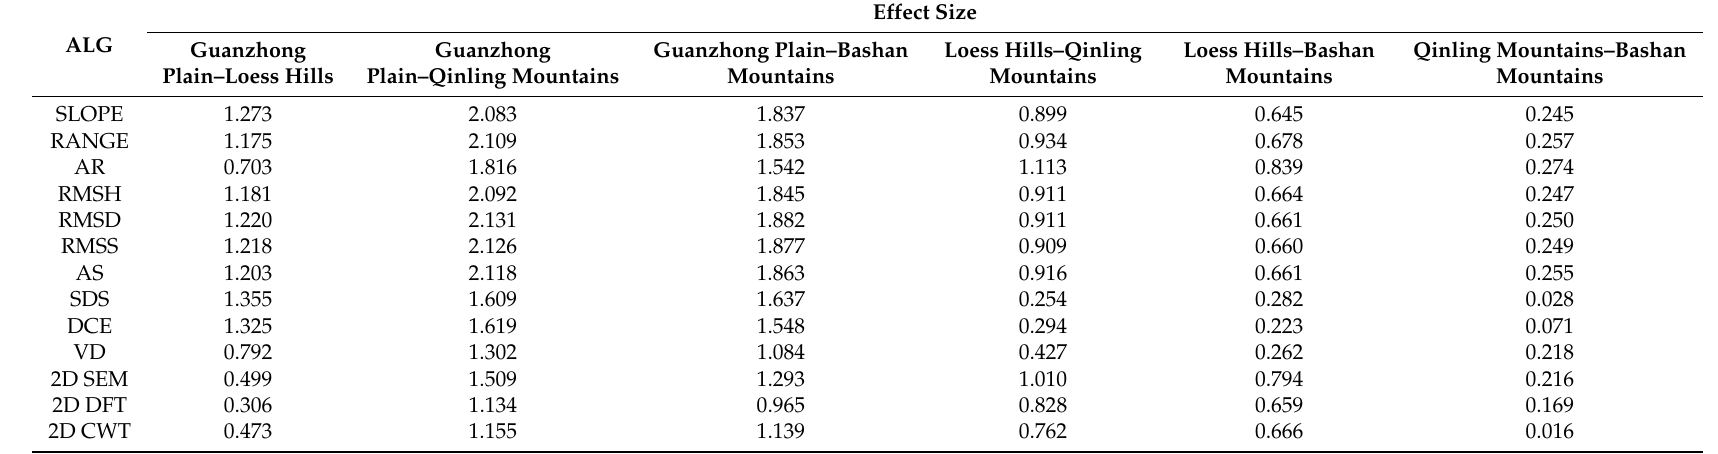
Table 2. Effect size for different roughness values in different